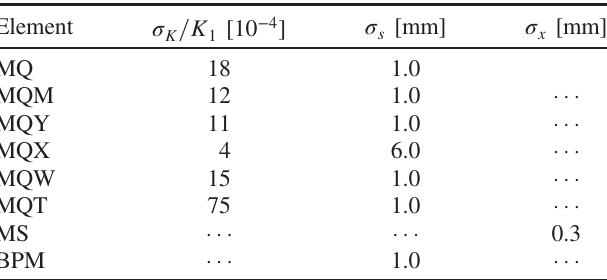
TABLE I. Estimates for the LHC gradient and misalignment errors. MQ are focusing and defocusing quadrupoles, MS are sextupoles. The values of the magnet errors are derived from magnetic measurements of [9,10].